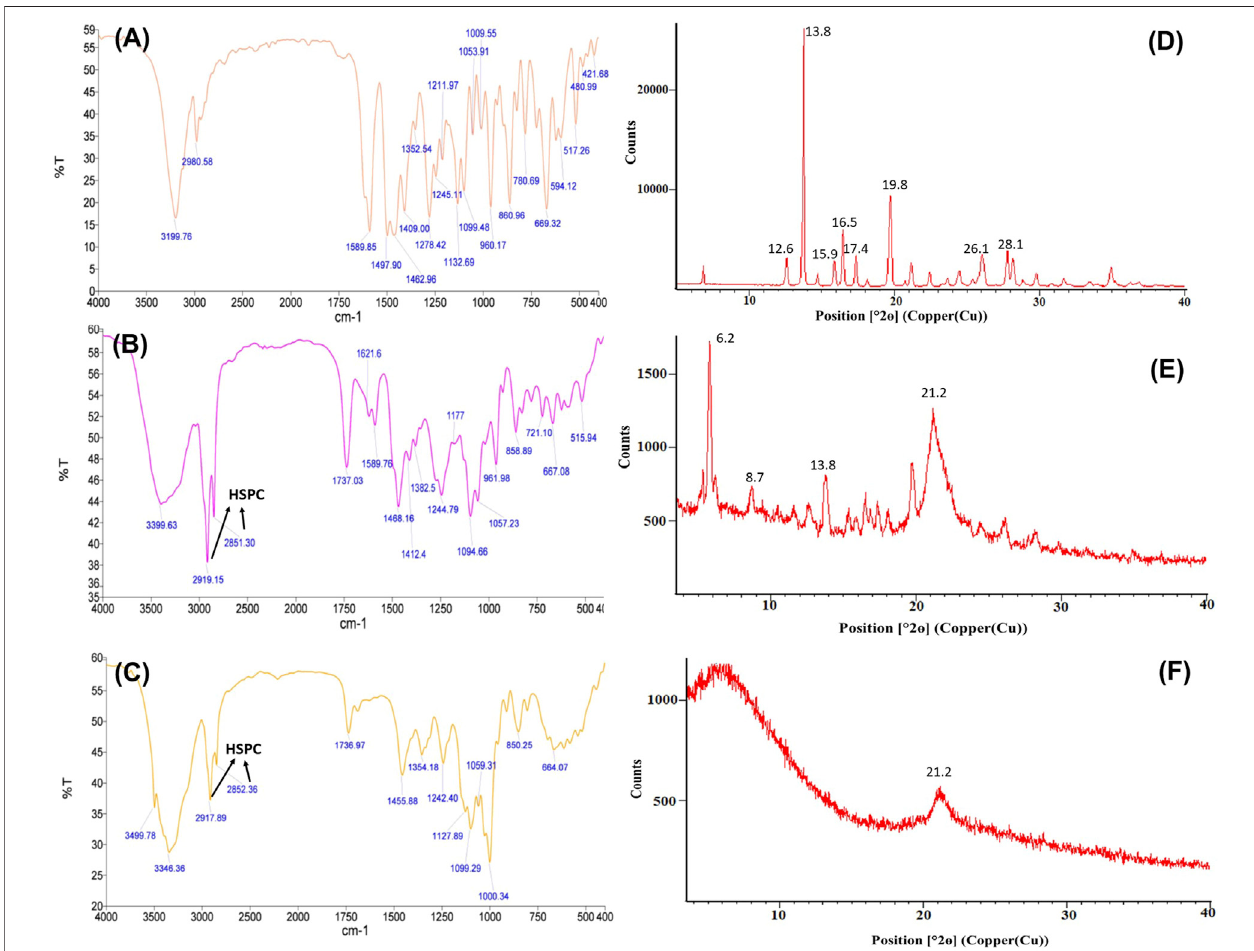
FIGURE 2 | FTIR spectra of voriconazole (A) , physical mixture containing voriconazole, hydrogenatedsoyaphosphatidylcholine, dipalmitoylphosphatidylcholine and cholesterol (B) , and optimized lipid nanovesicles (C) . The arrows indicate the respective peaks of HSPC in FTIR spectra. The corresponding PXRD diffractograms illustrate the crystalline nature of drug molecule (D) and physical mixture (E) , compared to the amorphous state of LNVs (F) , delineating the respective vital peaks.